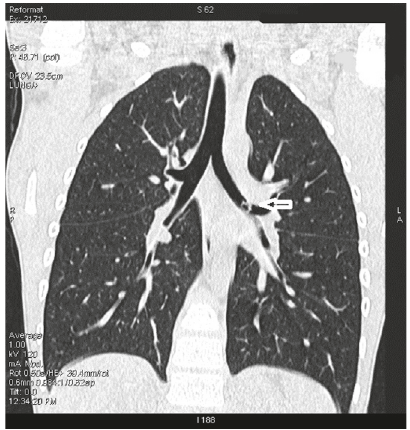
Figure 1: A low-dose CT thorax, at coronal plane, showing an intraluminal foreign body with an inverted U appearance (arrow) lodged at the distal left main bronchus measuring 5.4 × 6.8 × 7